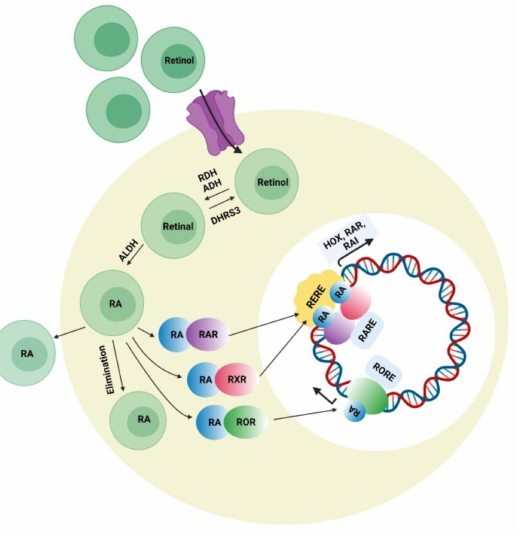
Figure 3. Retinoic acid (RA) signaling pathway. Retinoic acid is synthesized intracellularly from retinol, which first is converted into retinaldehyde by the enzyme alcohol dehydrogenase or retinol dehydrogenase. The reversible conversion of retinal to retinol is mediated by the enzyme retinal reductase (DHRS3). Retinal is irreversibly oxidized to become retinoic acid (RA) by the enzyme retinaldehyde dehydrogenase (ALDHs). Retinoic acid inside the cell binds to receptors present on the surface of the nucleus (RAR, ROR, and RXR) and recognizes consistent response elements (RARE, RORE, and RXRE) along with the DNA, which activates the expression of different target